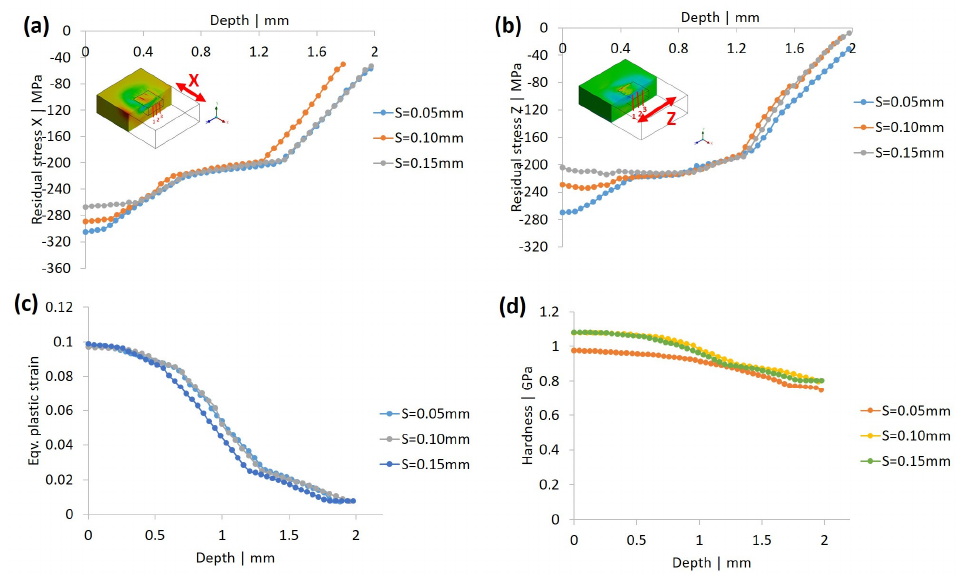
Figure 13. Effect of burnishing step-over on ( a ) residual stress along X (feed direction); ( b ) residual stress along Z (step-over direction); ( c ) plastic strain and ( d ) hardness at F = 1650 N, f = 300 mm/min.